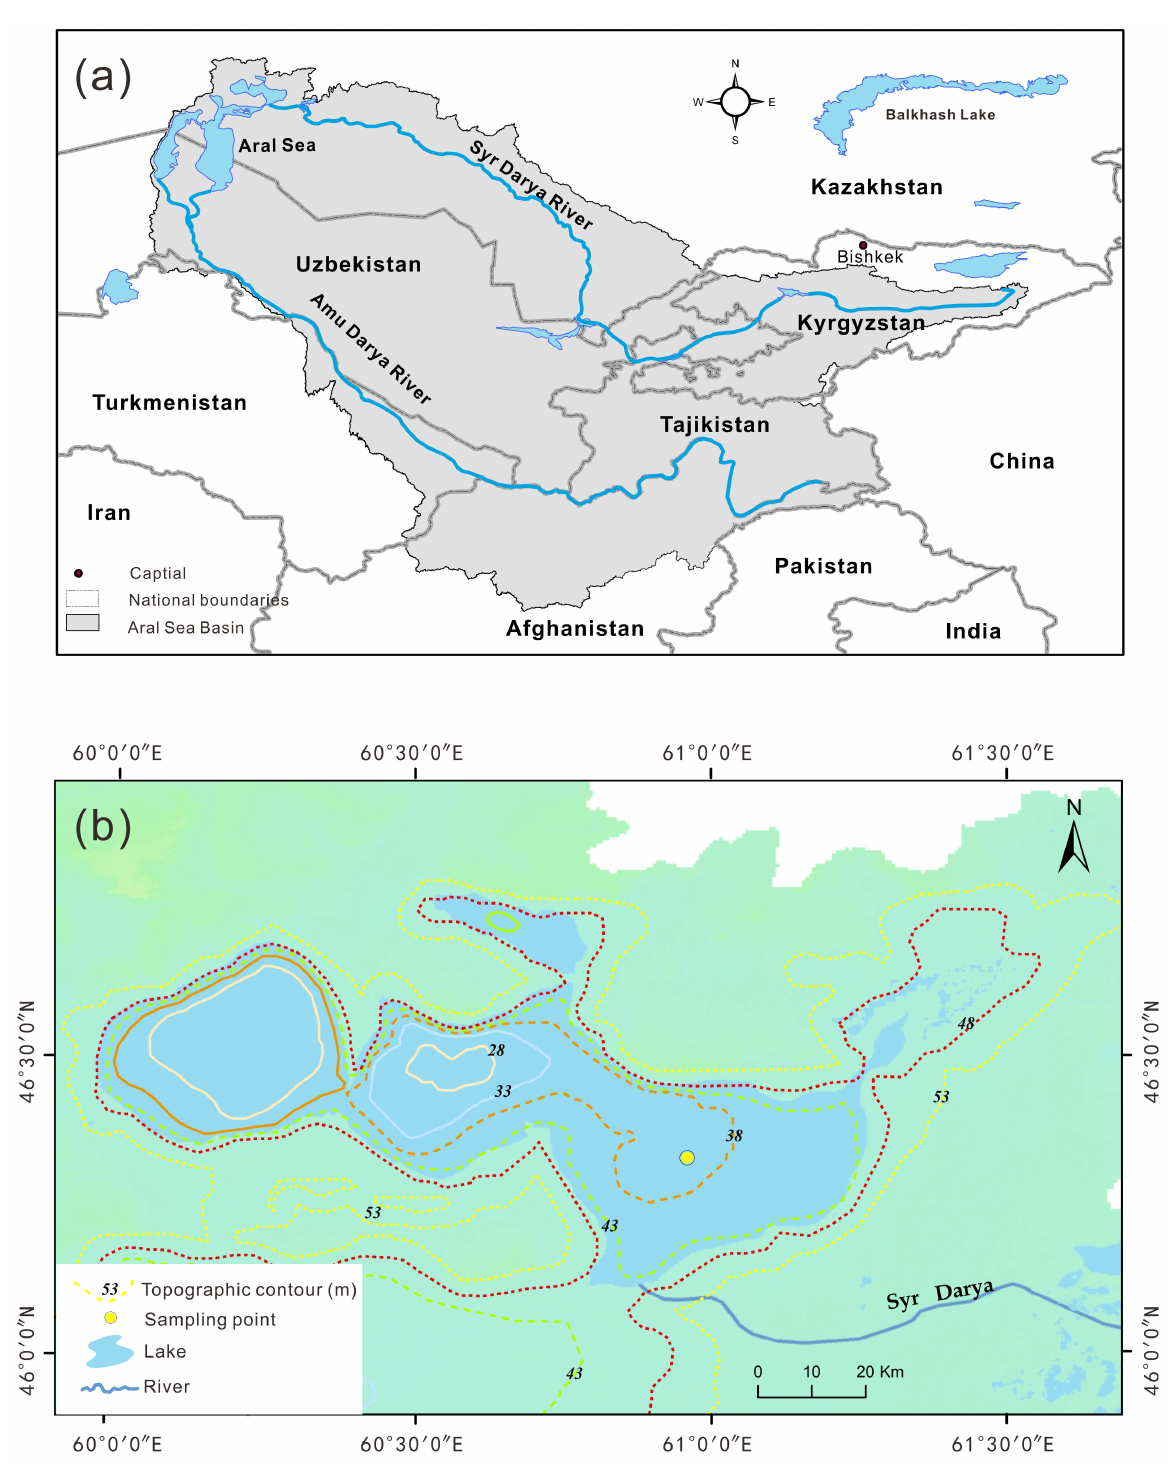
Figure 1. The location of the Aral Sea Basin ( a ) and the sampling point in the North Aral Sea ( b